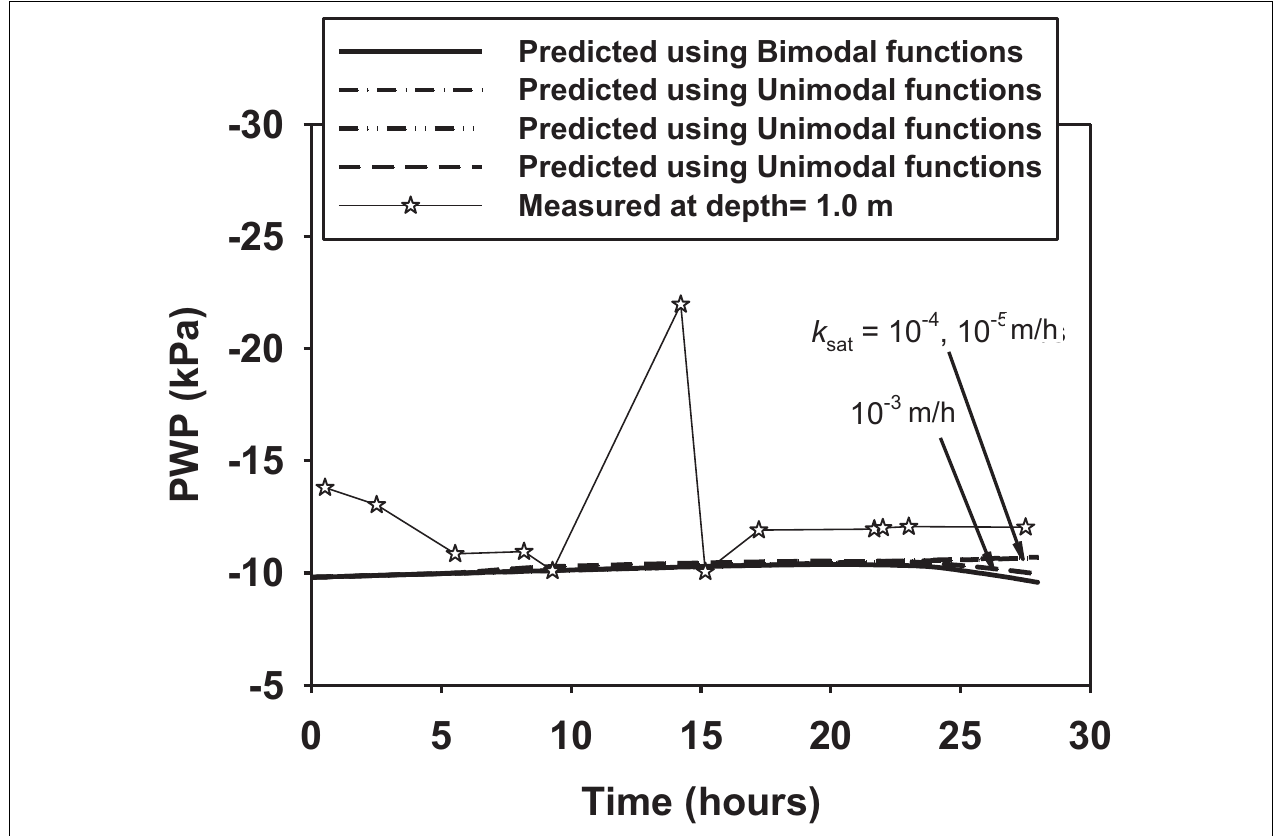
FIGURE 7 | Comparison between measured PWP and predicted PWP at the depth of 1.0